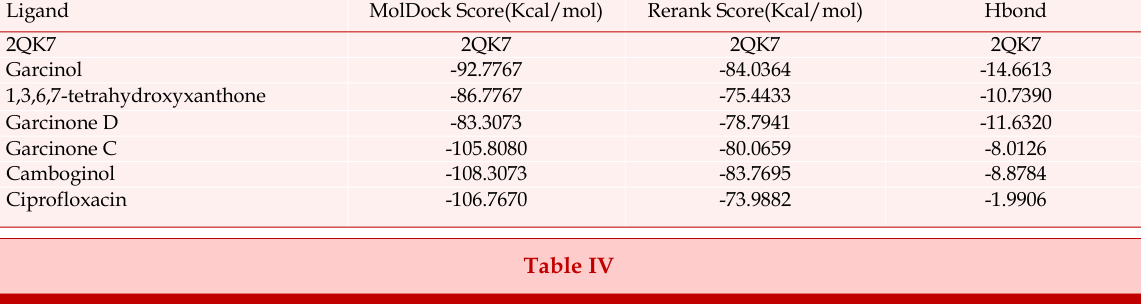
H-bond interaction with the best ligands from G.pedunculata along with ciprofloxacin